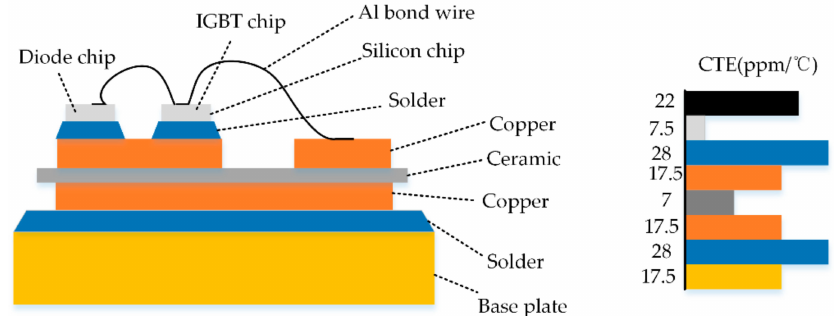
Figure 1. Insulated Gate Bipolar Transistor (IGBT) module structure and material coe ffi cient of thermal expansion